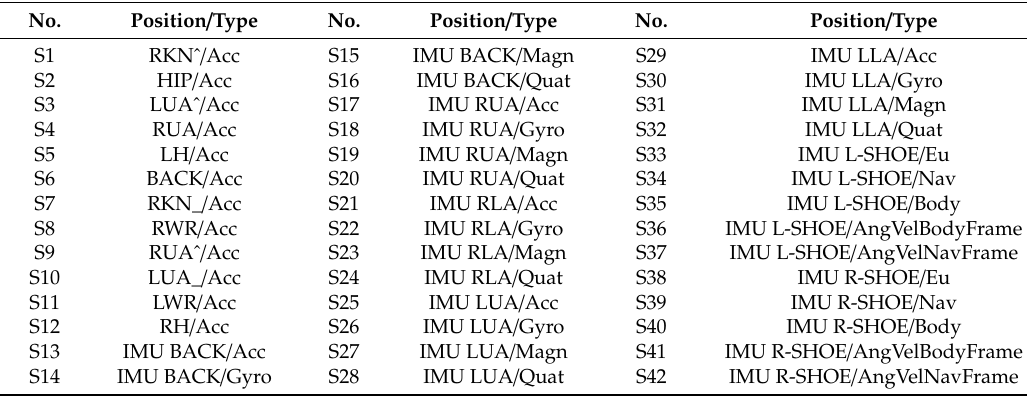
Table 1. The sensor types and their body positions utilized in this